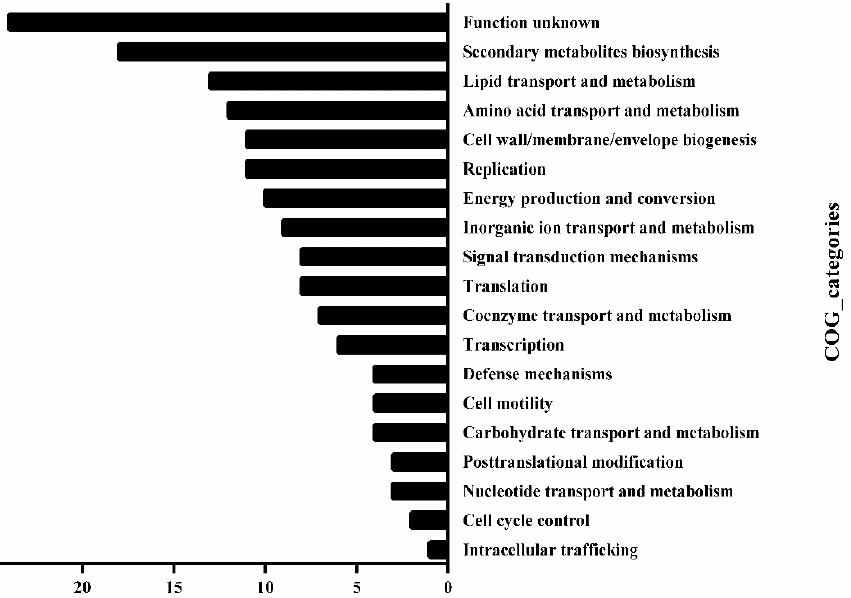
Figure 3. Functional classification of HsdM substrates in BCG. Substrate gene functions were classified by comparing them in the COG database.